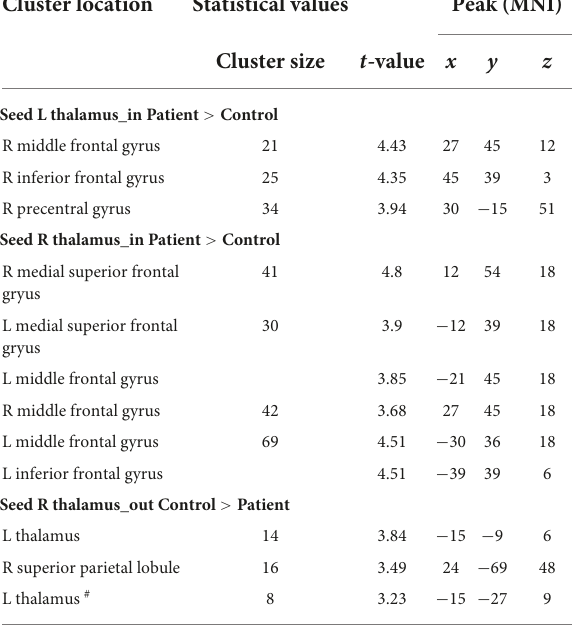
The MNI coordinates and t -values for the FC results. Threshold for significant clusters reportedherewassetat p <